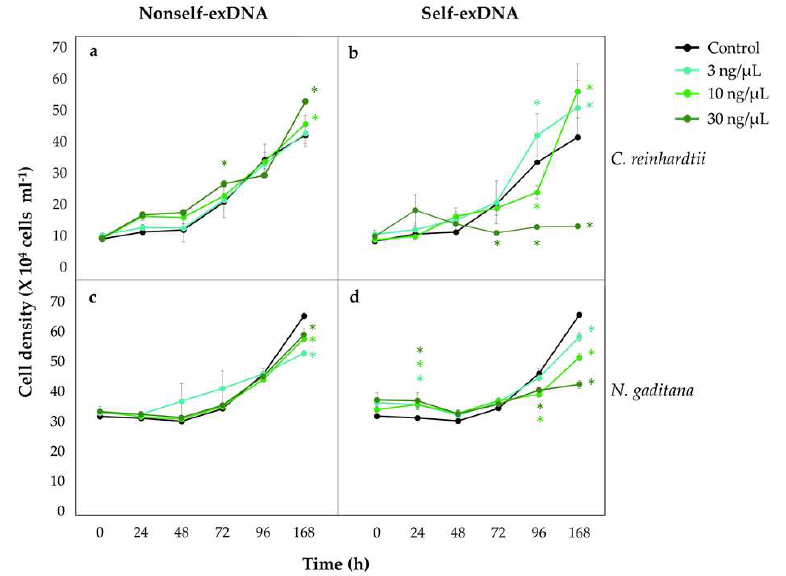
Figure 1. Cell density of Chlamydomonas reinhardtii ( a , b ) and Nannochloropsis gaditana ( c , d ) after the exposure to different concentrations of nonself- and self-exDNA. Controls (black lines and dots) are represented by microalgae grown in Bold’s Basal Medium (BBM) and Artificial Seawater Medium (ASW) for C. reinhardtii ( a , b ) and N. gaditana ( c , d ), respectively. Different coloured * indicate statistically significant differences between treatments and the control at each time (post hoc ANOVA, Dunnet test with p < 0.05).